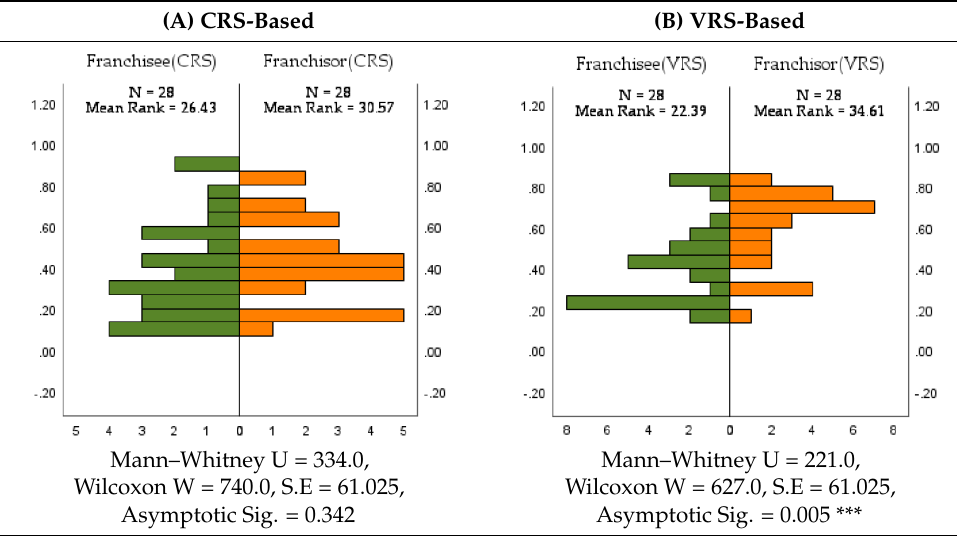
Table 7. Analysis result of Mann–Whitney U test between premium and mainstream coffee